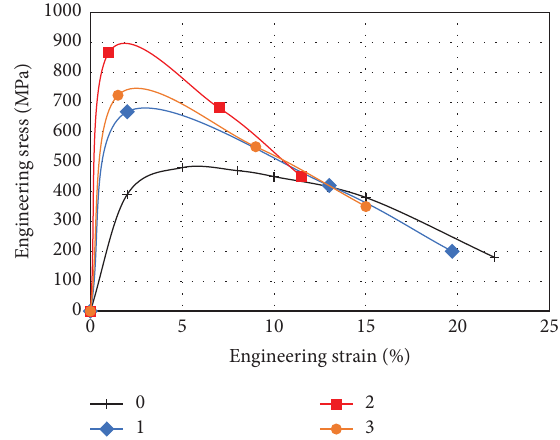
Figure 17: Tensile results of samples obtained after SPD processing by the TE method ( e � 4.6) and rolling in the temperature range of 350–200 ° C: 0 indicates after the TE; 1 indicates after the 1st stage of rolling ( e � 0.91); 2 indicates after the 2nd stage of rolling ( e � 2.19); 3 indicates after the 3rd stage of cross rolling at 385 ° S ( e � 3).